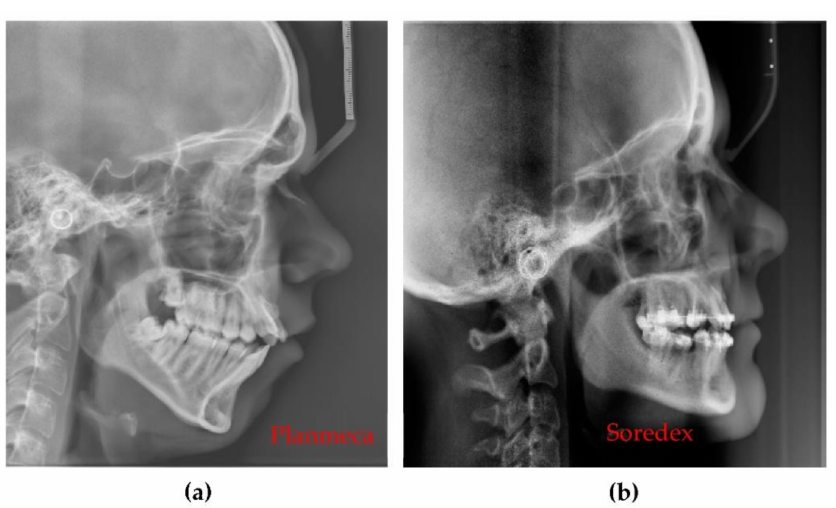
Figure 14. Cephalometric radiographs performed with ( a ) the Planmeca unit and with ( b ) the Soredex